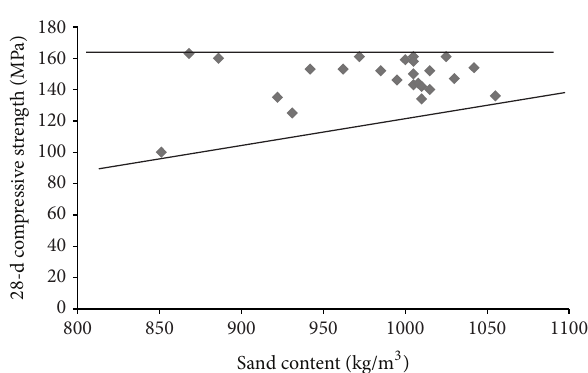
Figure 2: Variation of 28-d compressive strength with sand content.